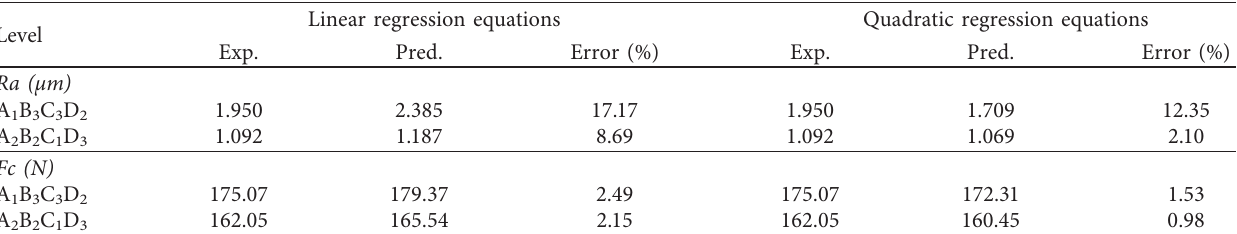
Figure 8: The deviations between the actual and predicted values for Fc (a) and Ra (b). Table 8: The verification test